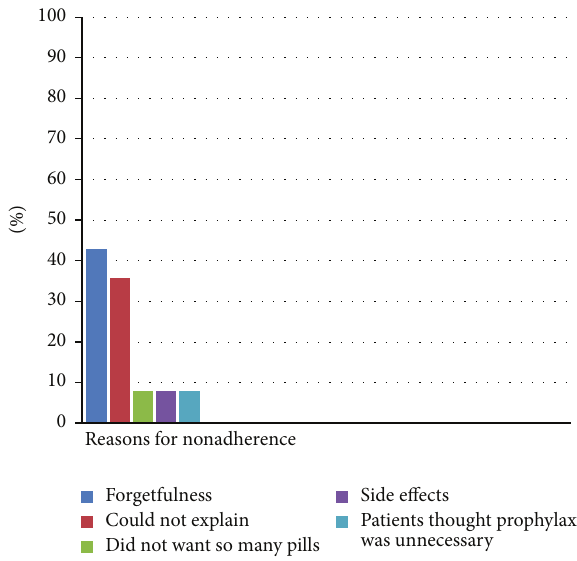
Figure 3: The most important causes of nonadherence amongst PMR/GCA